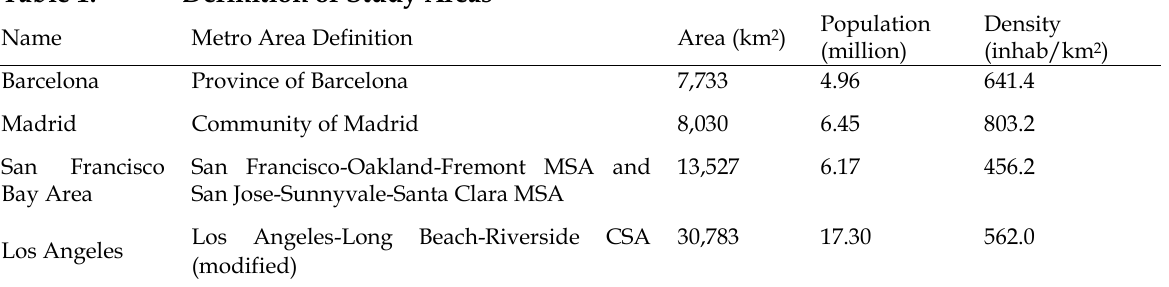
Definition of Study